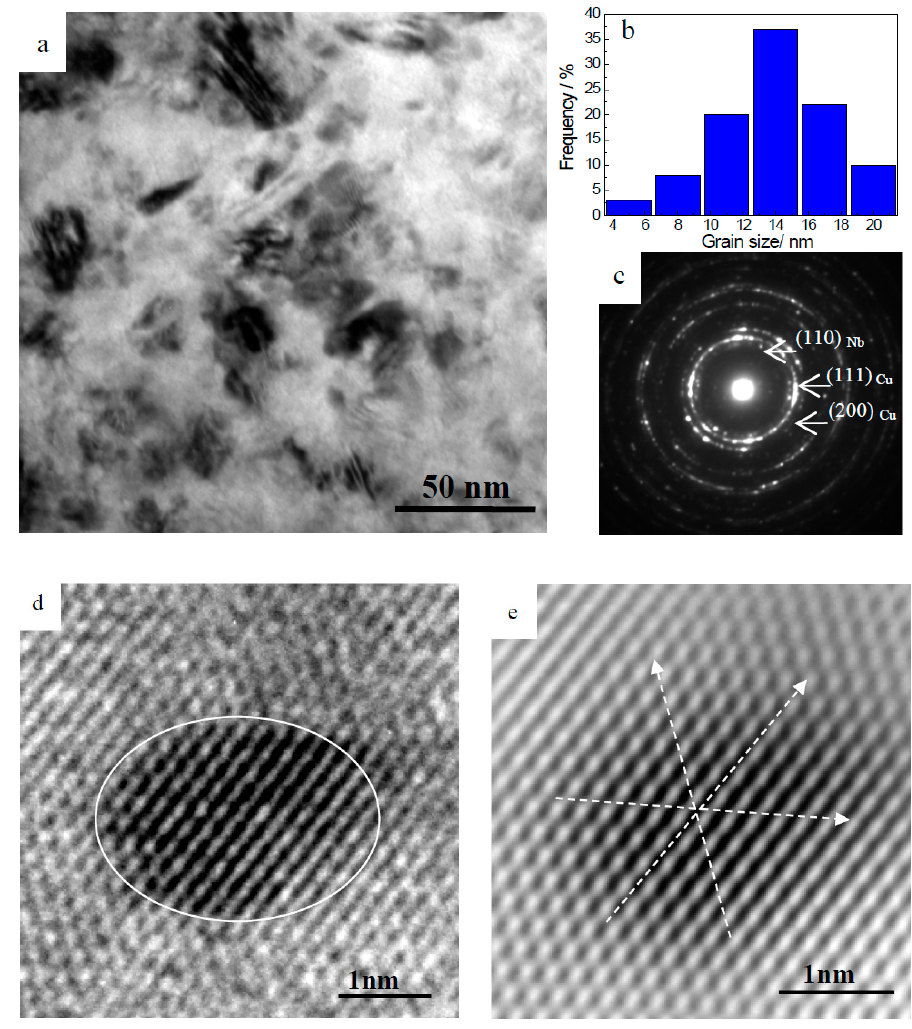
Figure 3. TEM and HRTEM images of MA-ed Cu-Nb powders annealed at 400 ◦ C for 1 h. ( a ) bright field (BF) image; ( b ) Cu grain size distribution histogram; ( c ) EDP; ( d ) HRTEM image of a Nb-rich cluster, which is outlined by the white line; ( e ) the corresponding Fourier-filtered image of Figure ( d ). White arrows were superimposed on different lattice planes to indicate their position.